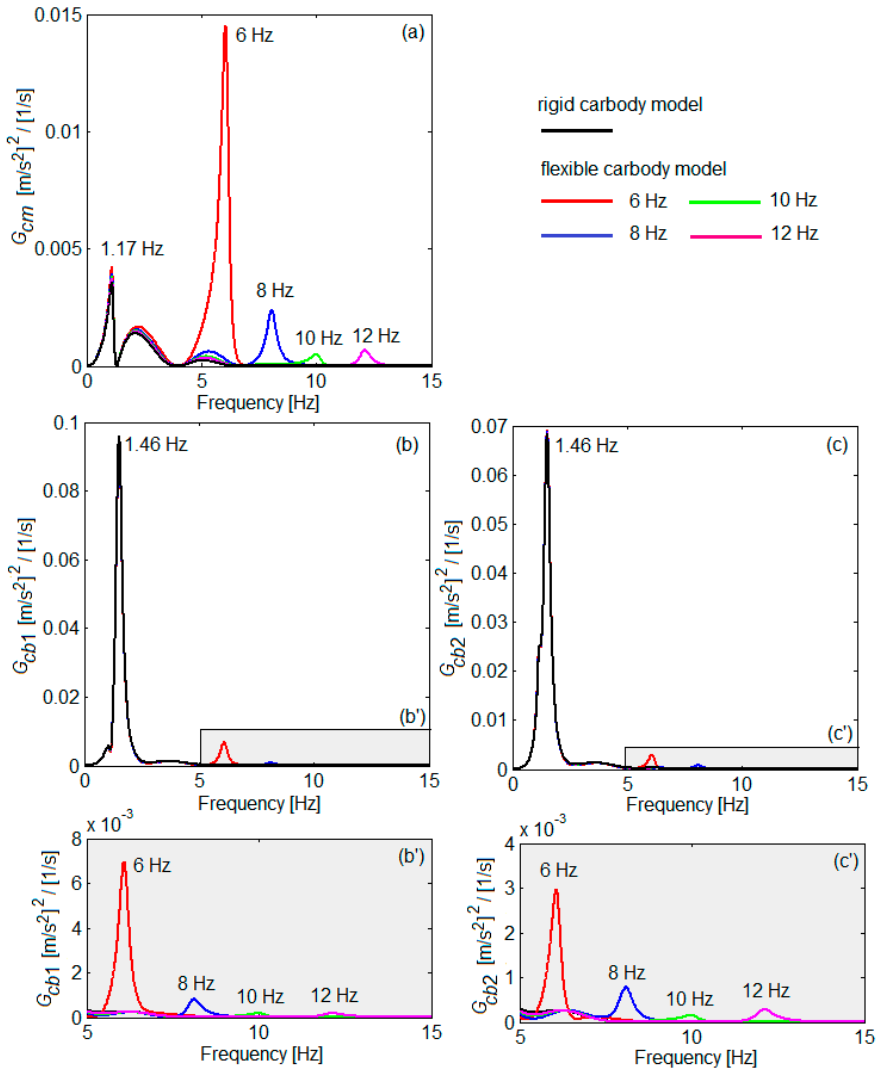
Figure 3. Influence of the vertical bending upon the power spectral density of the carbody acceleration: ( a ) at the carbody centre; ( b ) against the front bogie; ( c ) against the rear bogie.